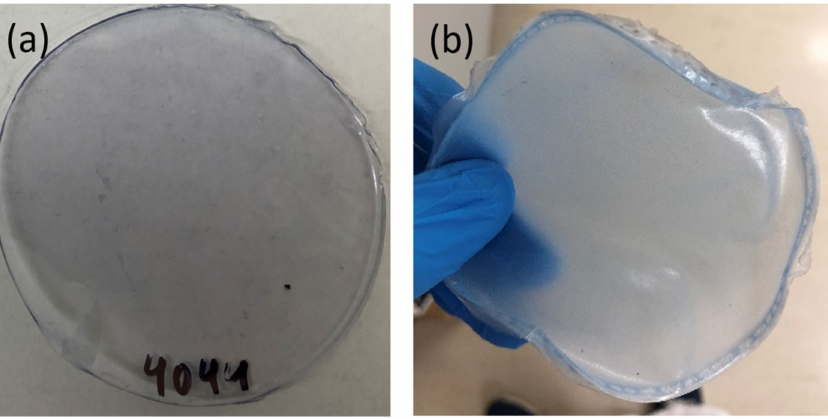
Figure 4. Photographic picture of ( a ) TSNP/PLA and ( b ) TSNP/PCL